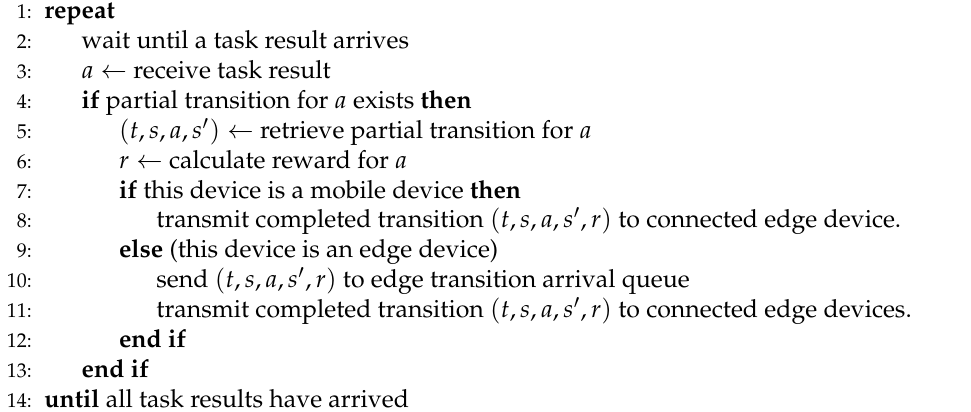
Algorithm 6 Transition completion algorithm for mobile and edge